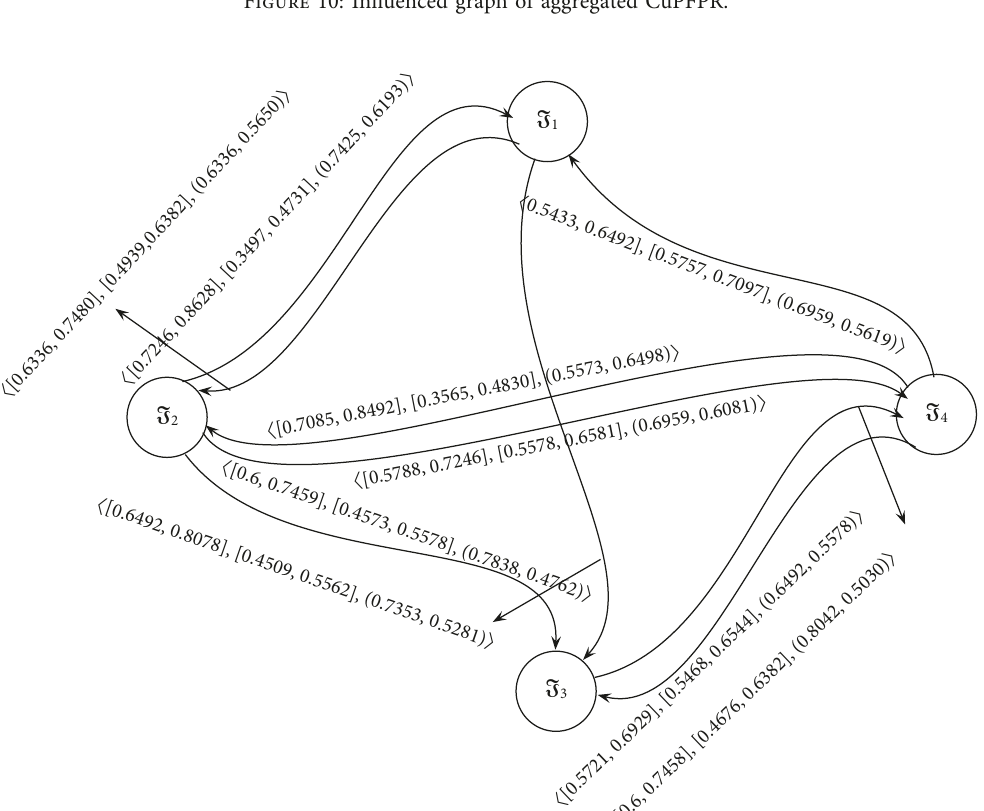
Figure 10: Influenced graph of aggregated CuPFPR.